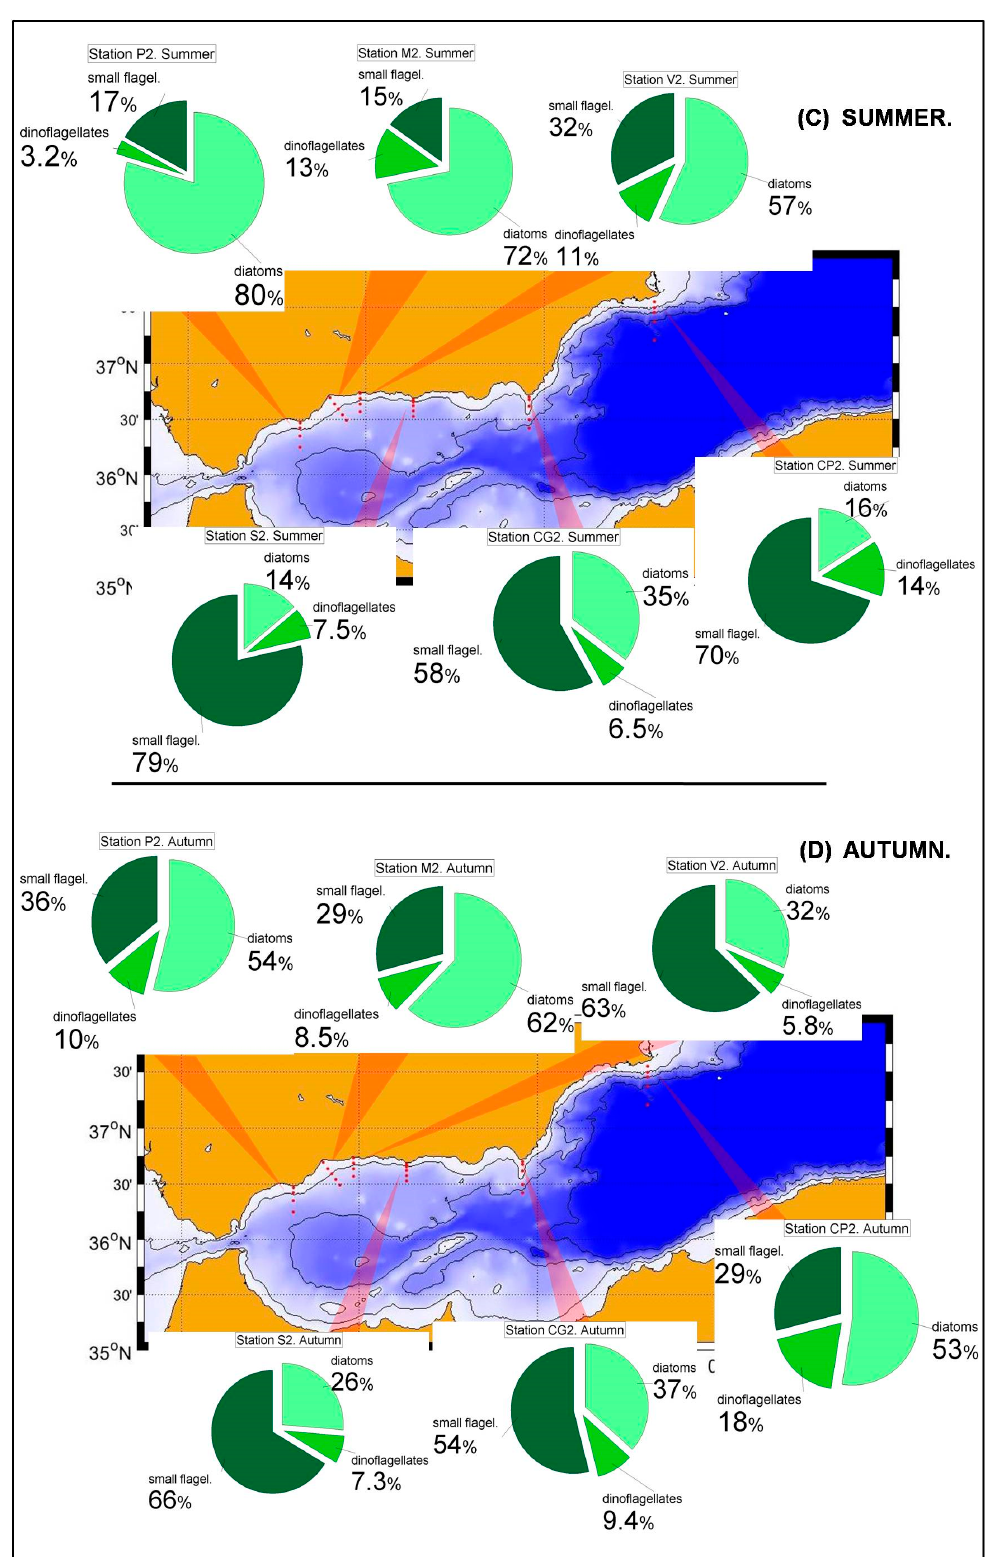
Figure 6. Relative abundances expressed as percentages for the Alboran Sea and Cape Palos for diatoms (light green), small flagellates (dark green) and dinoflagellates (intermediate green) integrated from the sea surface to 100 m. ( A – D ) correspond to winter, spring, summer and autumn respectively.